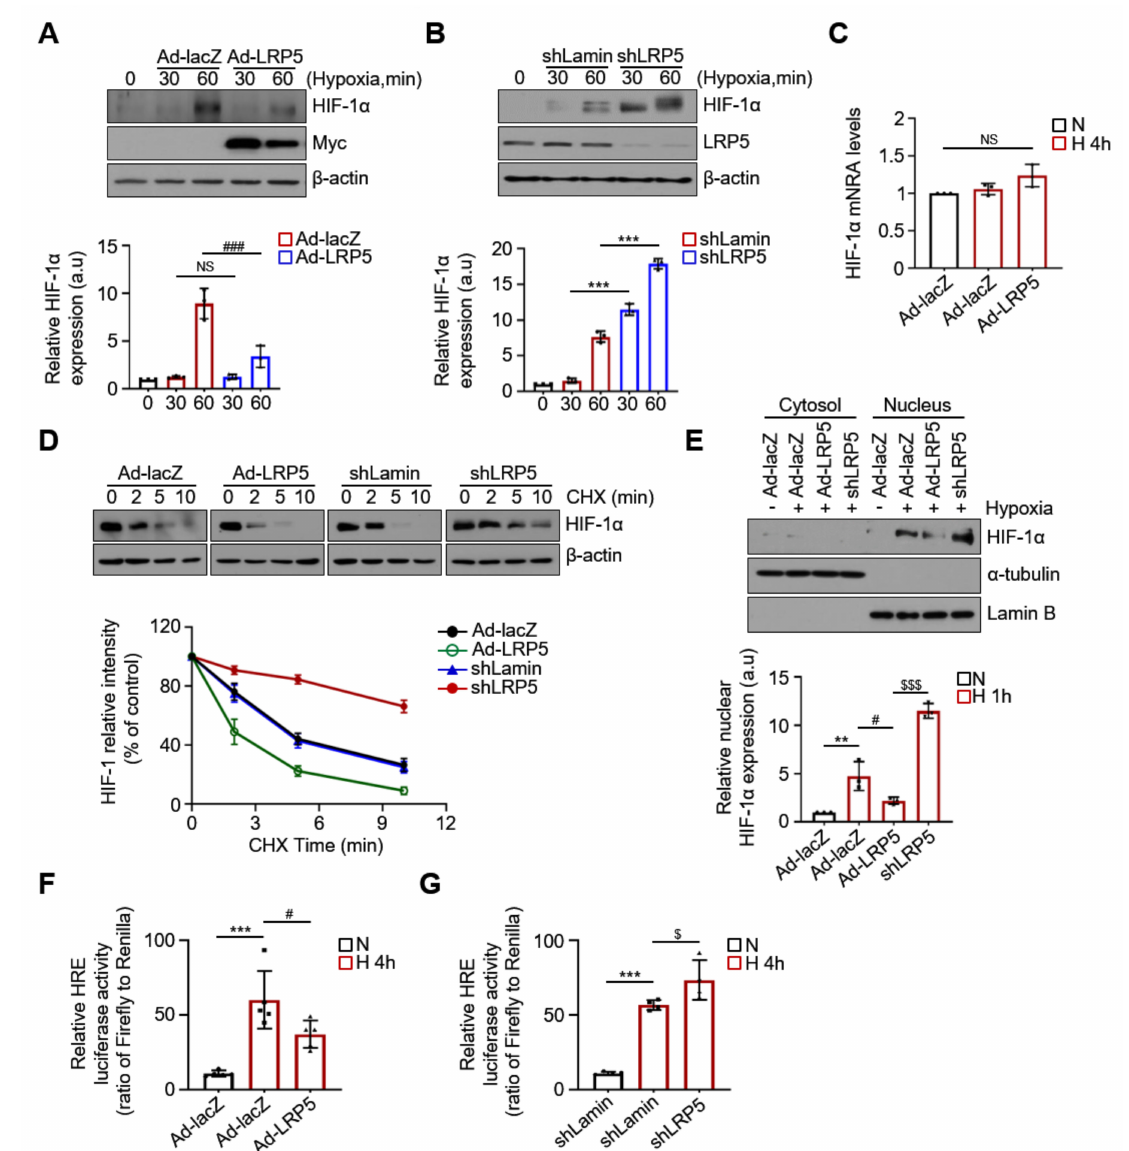
Figure 3. LRP5 aggravates HIF-1 α stability in hypoxic cardiomyocytes. ( A ) Ad-lacZ- and Ad-LRP5-, and ( B ) shLamin- and shLRP5-infected cardiomyocytes were exposed to either normoxia or hypoxia for 30 and 60 min and harvested for western blotting. Representative western blot analysis showing HIF-1 α protein levels in cardiomyocytes incubated for increasing times under hypoxia. n = 4/group. Means ± SD. ### p < 0.001 Ad-LRP5 versus Ad-lacZ; NS, no significance; *** p < 0.001 shLRP5 versus shLamin. ( C ) HIF-1 α transcript levels quantified using RT-qPCR analysis. Gene expression was normalized to the arithmetic mean of three control genes (GAPDH, β -actin, and α -tubulin). n = 3/group. Means ± SD. NS, no significance. ( D ) Representative half-life of the HIF-1 α protein in cardiomyocytes. Ad-lacZ-, Ad-LRP5-, shLamin-, and shLRP5-infected cardiomyocytes were co-infected with Ad-HIF-1 α and treated with CHX (50 µ g/mL) for the indicated times and then harvested at various time points for western blotting. Protein levels were normalized to β -actin levels. n = 4/group. ( E ) Representative western blots showing HIF-1 α expression in cytosolic and nuclear- fractionated lysates after exposure to hypoxic conditions for 60 min. α -tubulin and lamin B were used as cytoplasmic and nuclear protein controls, respectively. n = 4/group. Means ± SD. ** p < 0.01 versus Normoxia; # p < 0.05 Ad-LRP5 versus Ad-lacZ; $$$ p < 0.001 shLRP5 versus Ad-LRP5. ( F , G ) Transactivation of HRE-luciferase activity. Cardiomyocytes were co-transfected with the HRE luciferase reporter and pRL-TK vector (control for transfection efficiency) along with ( F ) Ad-lacZ- or Ad-LRP5 ( G ) shLamin- or shLRP5- infection. Relative luciferase activity was the ratio of luciferase over renilla activity. Means ± SD. *** p < 0.001 versus Normoxia; # p < 0.05 Ad-LRP5 versus Ad-lacZ ( F ) or *** p < 0.001 versus Normoxia; $ p < 0.05 shLRP5 versus shLamin ( G ). All images shown are representative of those obtained from at least three independent